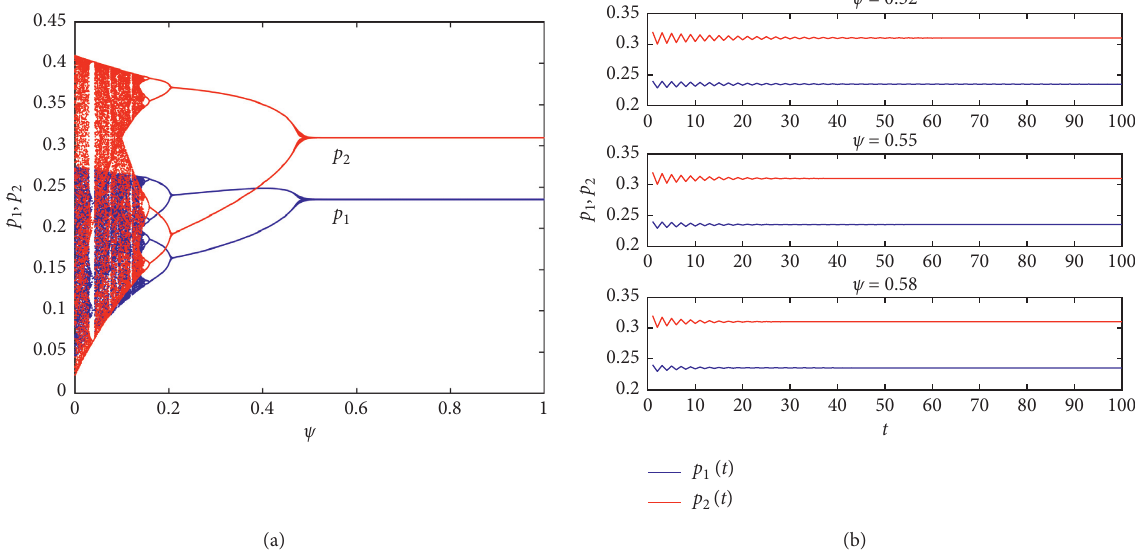
Figure 10: (a) Bifurcation diagram for system (62) with respect to the controlling factor ψ . (b) Evolutions for system (62) with various values of ψ